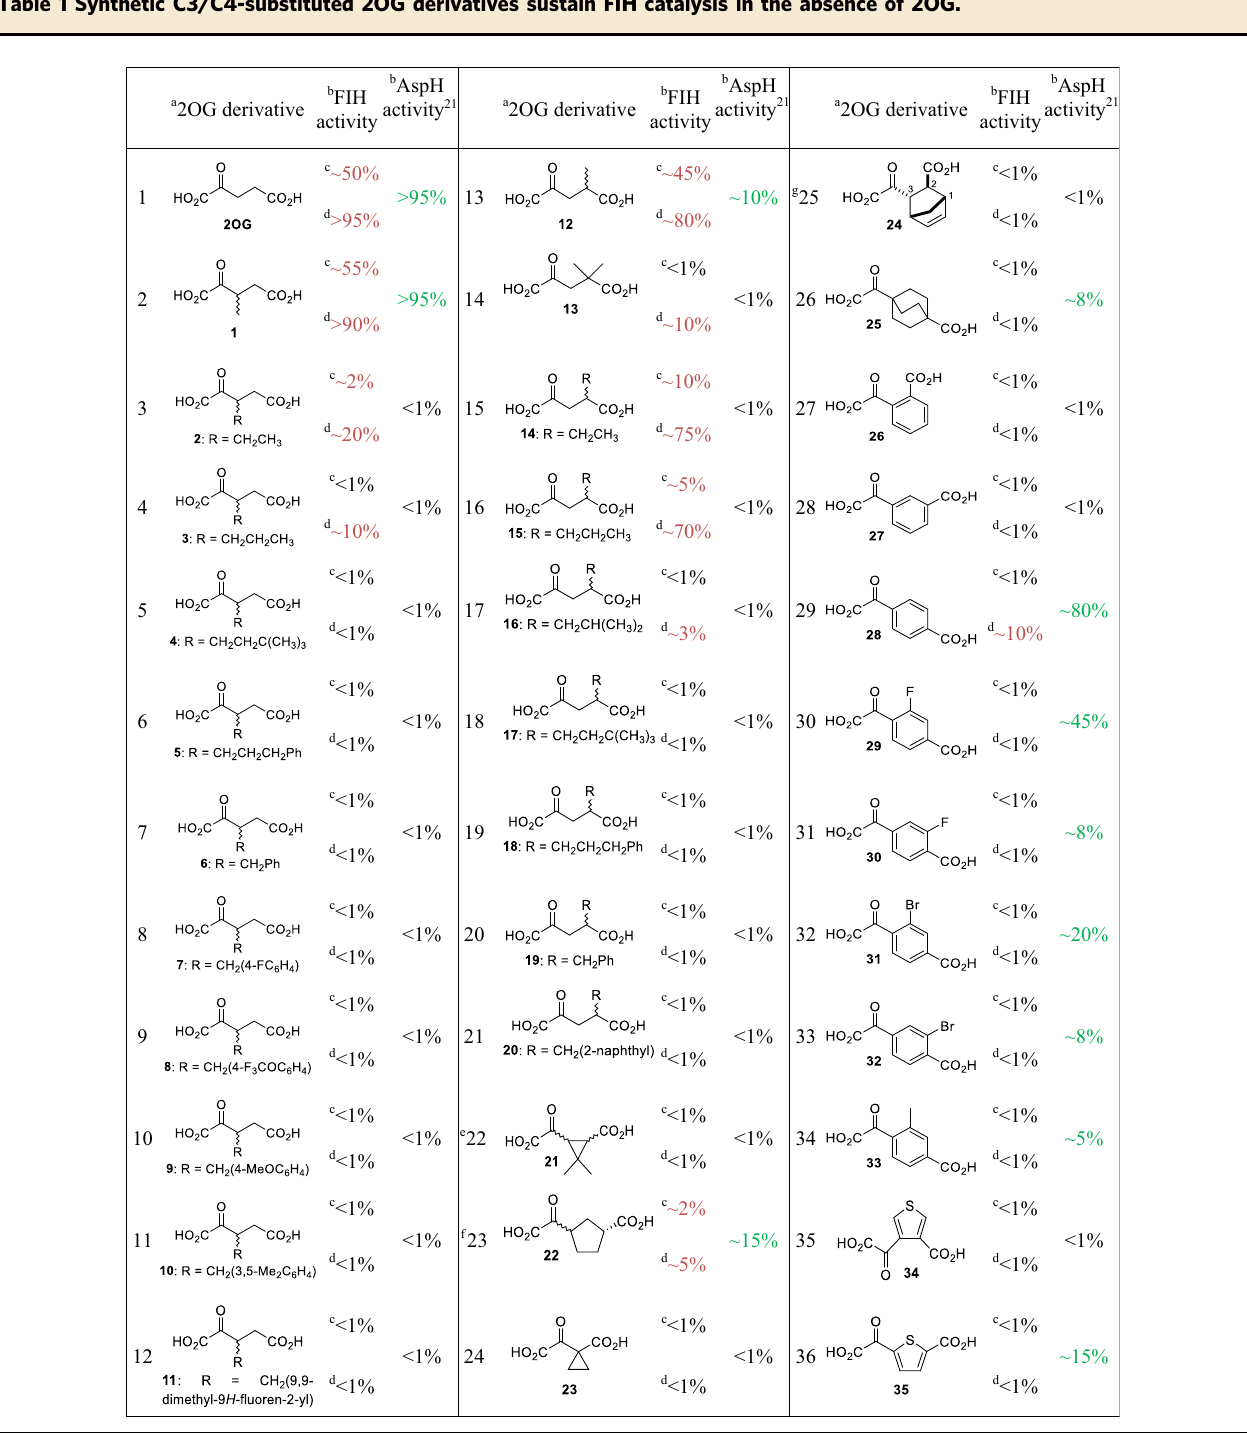
Table 1 Synthetic C3/C4-substituted 2OG derivatives sustain FIH catalysis in the absence of